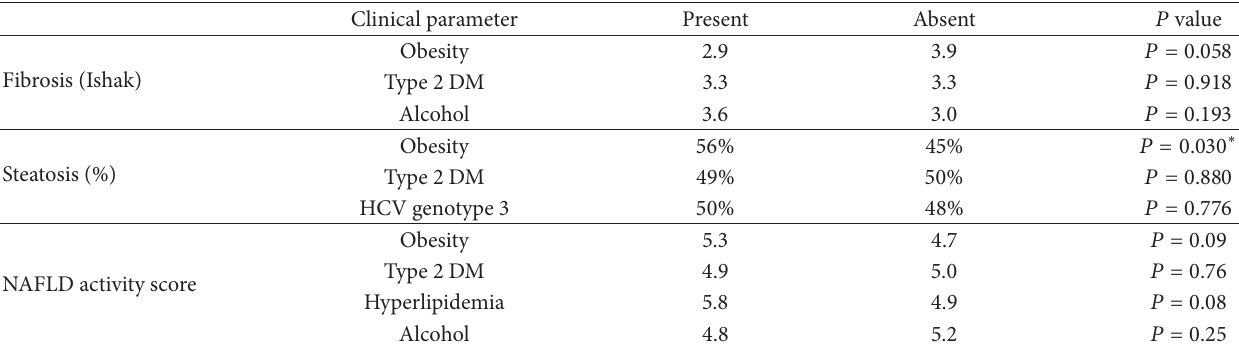
Table 2: Clinical parameters versus fibrosis, steatosis, and nonalcoholic fatty liver disease (NAFLD) activity score [36] in the study group by Student’s 𝑡 -test. Present: with the clinical parameter; absent: without the clinical parameter; Ishak: Ishak’s fibrosis staging system [35]; ∗ statistically significant ( 𝑃 < 0.05 ); type 2 DM: type 2 diabetes mellitus.